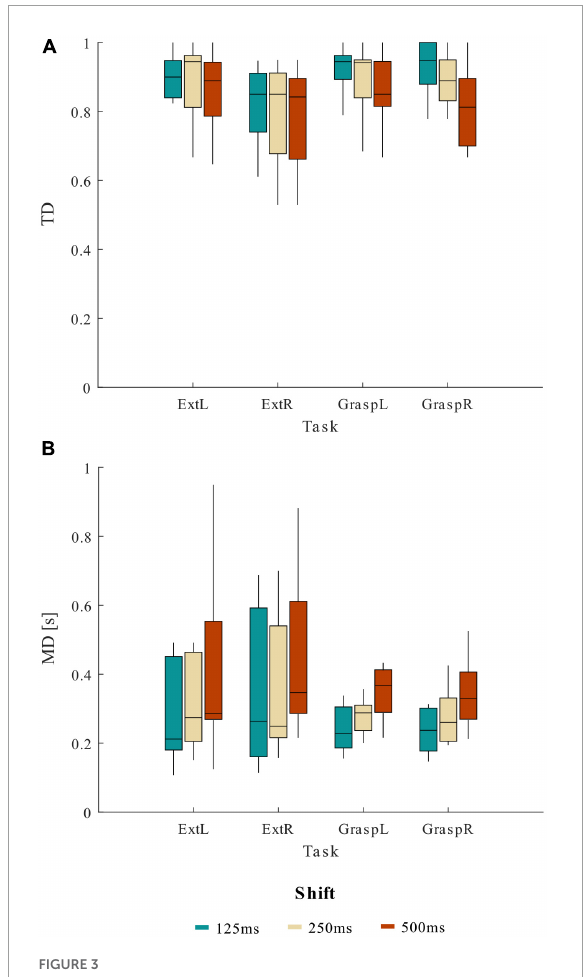
FIGURE3 Distribution (boxplots) of (A) true detection (TD) and (B) mean delay (MD) at the various shift values across 13 healthy participants, separately for the four motor tasks (ExtL, ExtR, GraspL,